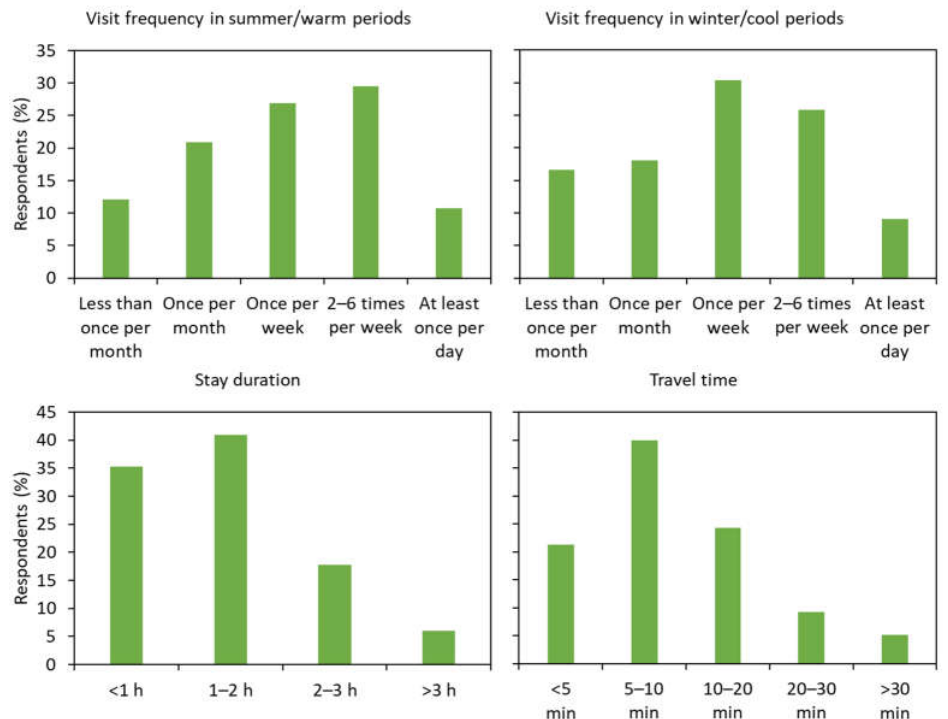
Figure 2. The visiting patterns of the respondents (%) are based on their park-visiting behaviors.